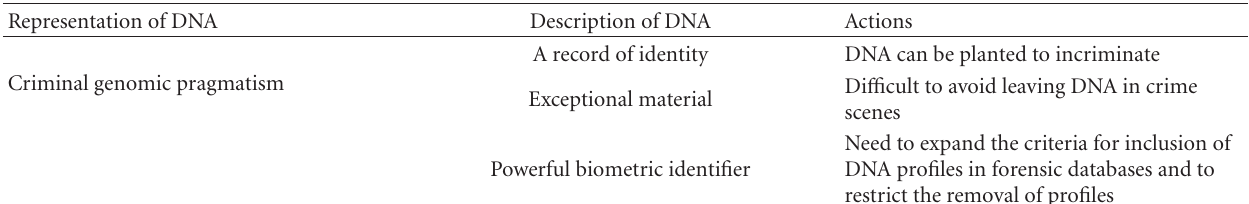
Table 2: Model for conceptualisation of meanings and uses attributed to DNA amongst